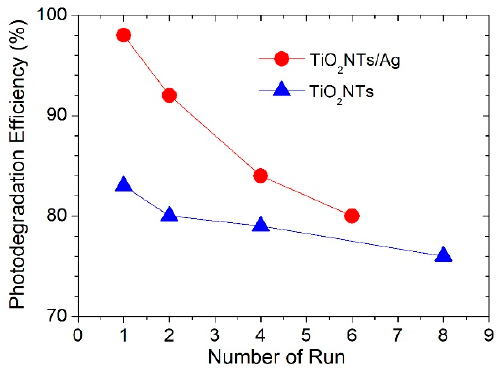
Figure 6. Photodegradation efficiency of TiO 2 NTs (blue triangle) and TiO 2 NTs/Ag (red circle) photocatalysts for degradation of MB.